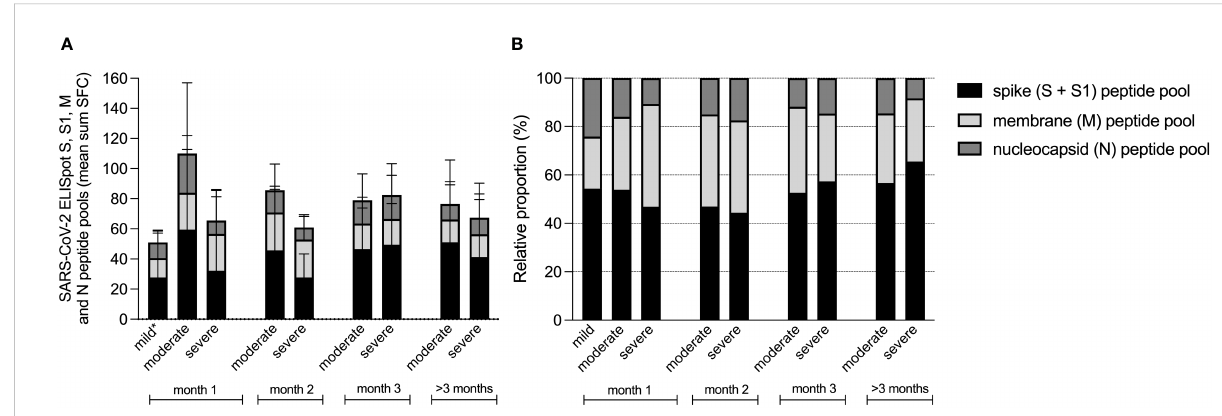
FIGURE 3 Contribution of spike, membrane and nucleocapsid peptide pools to the SARS-CoV-2 speci fi c T-cell response in patients with mild, moderate and COVID-19. Absolute (A) , and relative (B) proportion presented as mean percentage of spike (S and S1), membrane (M) and nucleocapsid (N) peptide pools of total SARS-CoV-2 speci fi c T-cell reactivity (sum SFC of S, S1, M and N). Data derived from sera that were collected per month after symptom onset, measured by ELISpot in patients with mild (n=58), moderate (n=90) and severe COVID-19 (n=100). *T-cell responses from mild disease group were obtained from thawn PBMCs, whereas the T-cell responses from hospitalized patient with moderate or severe disease were measured in fresh PBMCs. Comparability was ensured based on the presence of a similar mitogen response between both sample